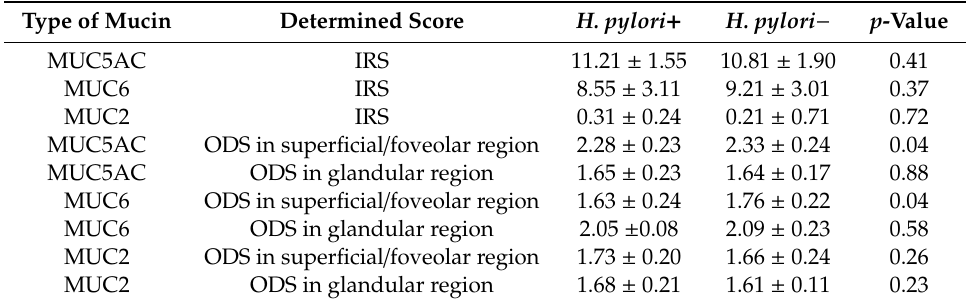
Table 1. Comparison of mucin expression in the antral mucosa between H. pylori + and H. pylori − groups. Type of Mucin